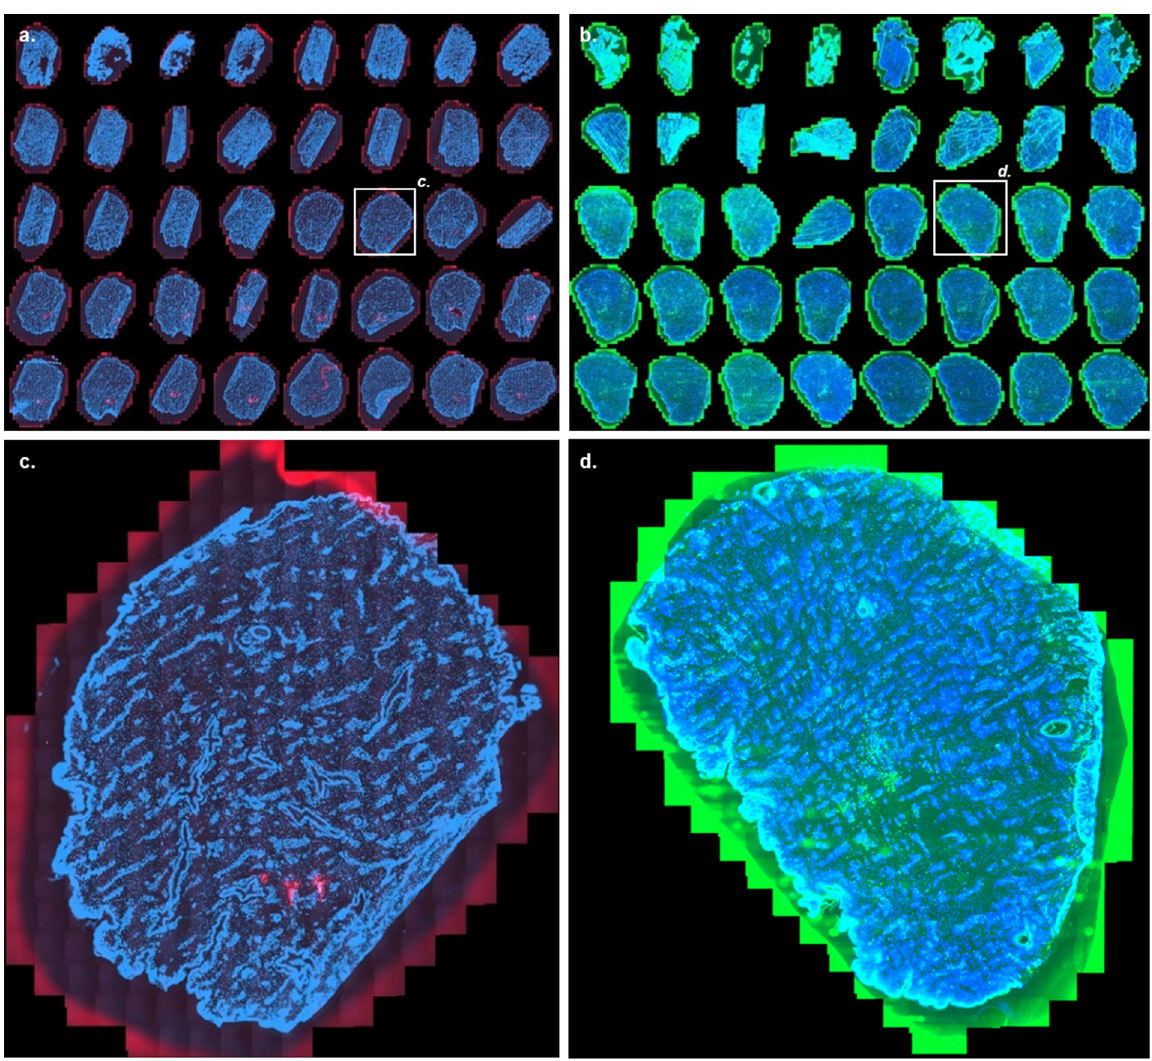
Figure 4. Cutaneous distribution as a function of depth of Cy5 labeled mRNA and eGFP after ID delivery of the former and eGFP expressing mRNA using the MicronJet™600 hollow microneedle injector. The images show the Cy5 labeled mRNA (red), eGFP (green), and DAPI (blue) signal 48 h after injection of the polymer formulations containing 1 µg of either Cy5 labeled mRNA or eGFP expressing mRNA using the hollow microneedle MicronJet™600 injector. ( a ) Cy5 labeled mRNA signal going from a skin depth of 10 to 400 µm. As with conventional ID injection, the Cy5 signal only begins to be visible in the dermis. ( b ) eGFP signal going from a skin depth of 10 to 400 µm after injection of eGFP expressing mRNA; again, as for the conventional ID injection, the eGFP signal is present in the viable epidermis, indicating that the site of mRNA delivery is not necessarily the site of protein expression. ( c , d ) Close-up images of the Cy5 labeled mRNA and eGFP signal from the dermal region (section 22, corresponding to a depth of 220 µm), 24 h after MicronJet™600 injection of the Cy5 labeled mRNA and eGFP expressing mRNA. For panels ( a , b ), high resolution images are available in Supplementary Material—File S2—high resolution montages of all 40 skin sections.